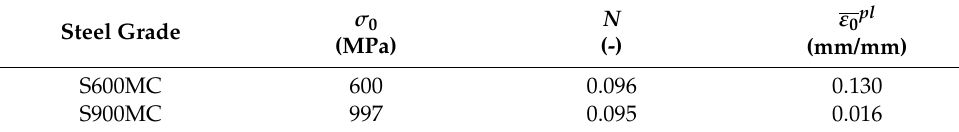
Table 4. Material properties for the S600MC and S900MC